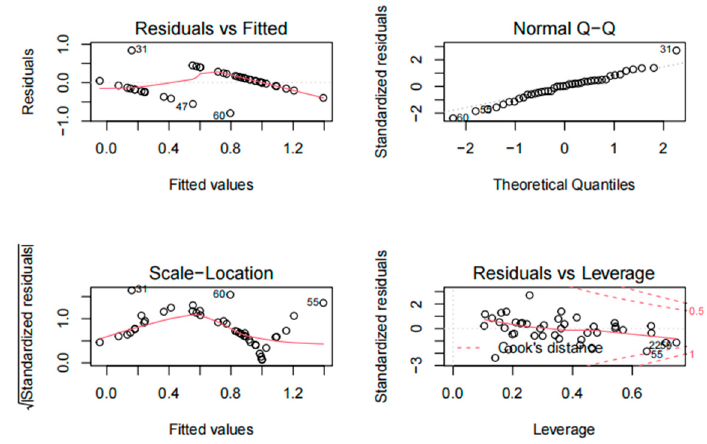
Figure 5. Model diagnostics graphs.